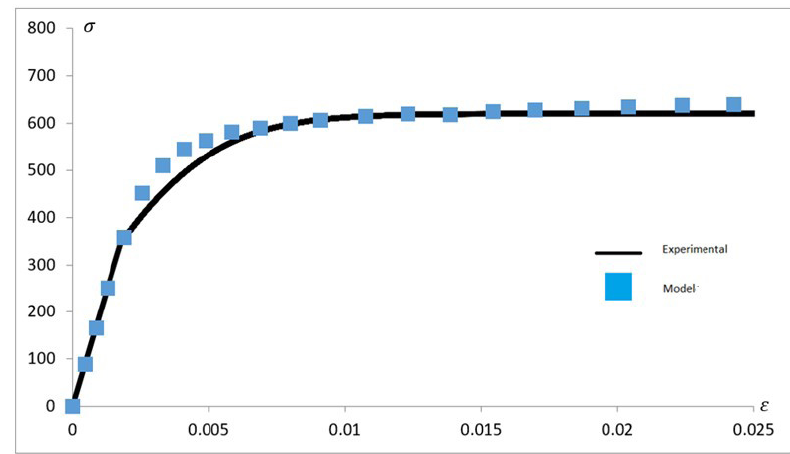
Figure 8. Comparative stress curve (MPa) - strain (mm / mm) - ε_3=